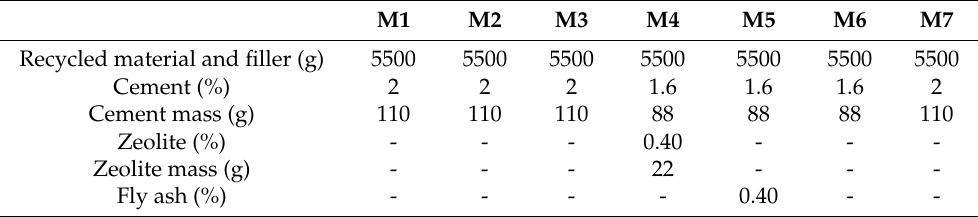
Table 4. Formulations of mixtures